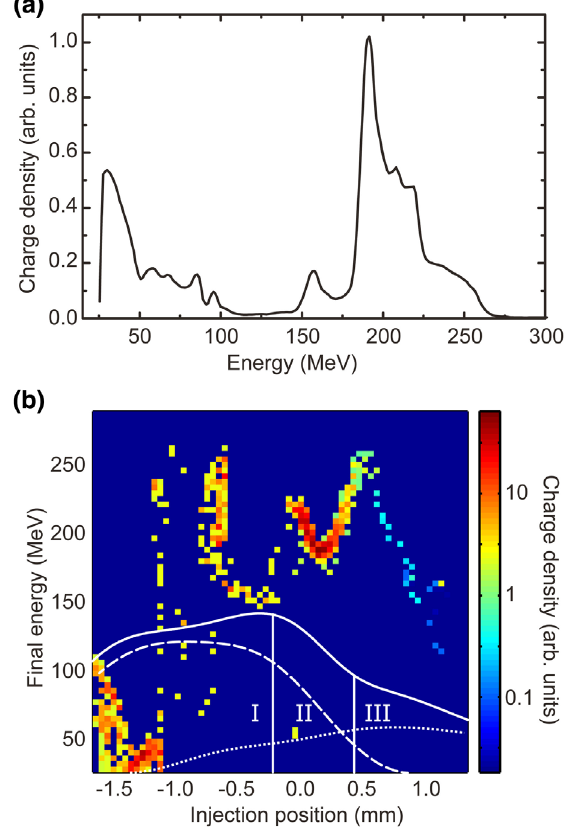
FIG. 3. Simulation results of the injected electrons at ∼ 0 . 9 mm after the phase-space evolution stops (only the electrons injected in the first bucket are considered). The electrons were originally ionized from N 2 only, while those ionized from He were not injected at all. (a) Spectrum of the electron bunch. (b) The plot of electron energy vs injection position (where they were ionized). The accelerated electrons were tagged and tracked throughout the simulation to obtain this plot. The overlay shows plasma density profiles of the first jet only (dashed curve), the second jet only (dotted curve), and the combination (solid curve; Roman numerals show different regions) with the same densities shown in Fig.